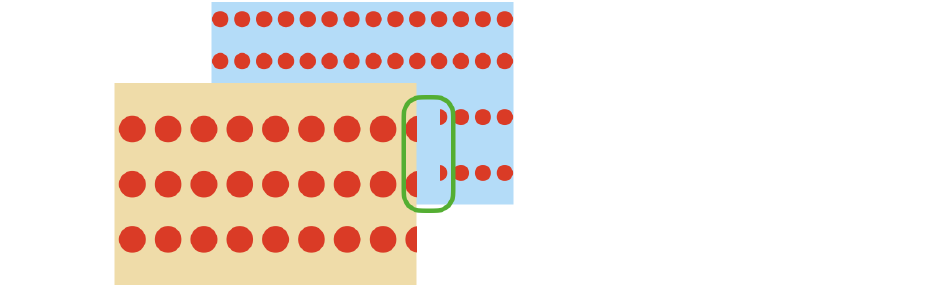
Figure 6. Behavior of the LiDAR’s lasers when they hit the edges of an object and another object is behind it.